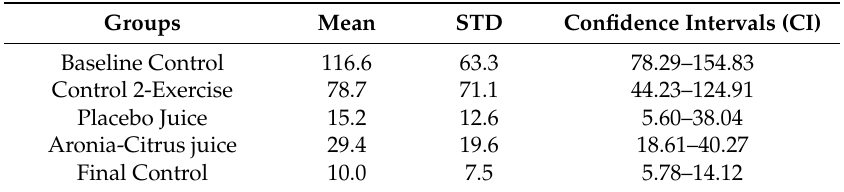
Figure 1. ( A ) Hepcidin standard at a concentration of 10 nM; and ( B ) endogenous hepcidin in a plasma sample. Table 1. Plasma concentrations of hepcidin in the different stages of the study. Data are shown in nM as mean ± standard deviation. Confidence intervals (CI) are included.